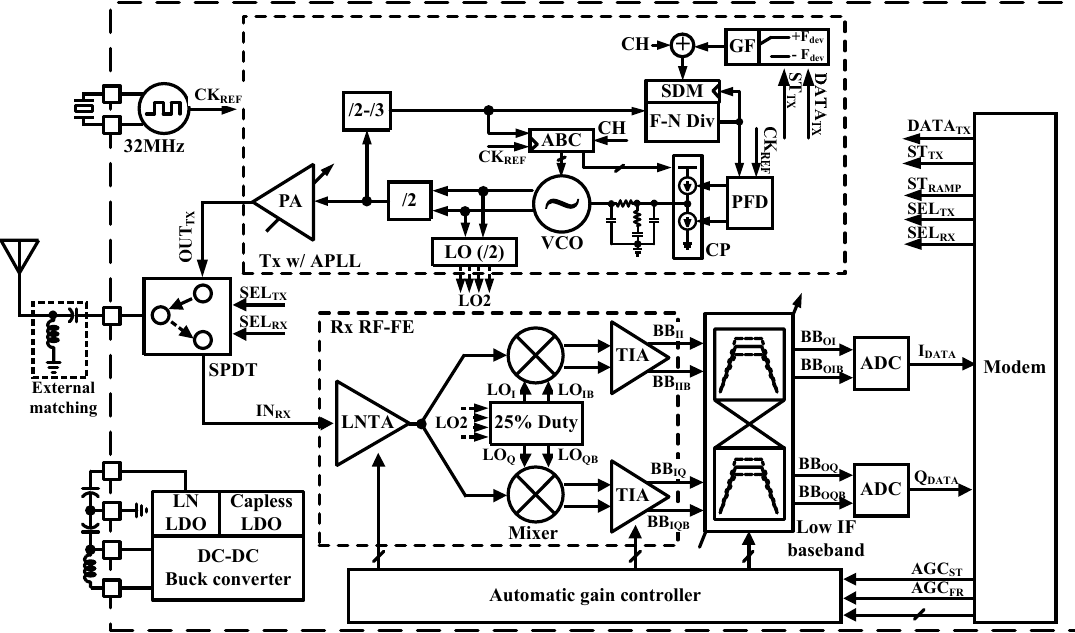
Figure 1. Block diagram of the proposed BLE transceiver with a Power Management Unit and Single Pole Double Throw.